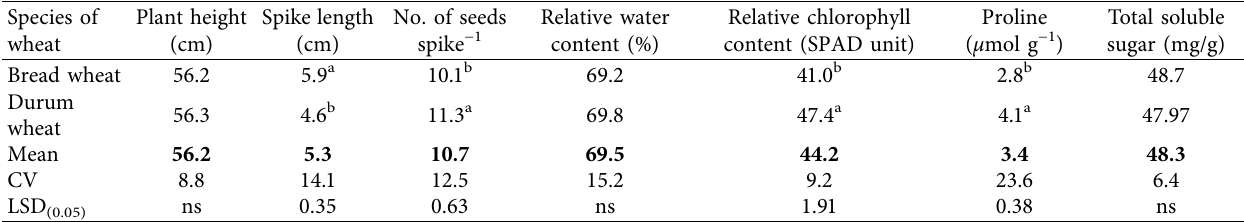
Table 5: Mean comparison of selected morphological, physiological, and biochemical characteristics of wheat species under well-watered and water stress conditions.